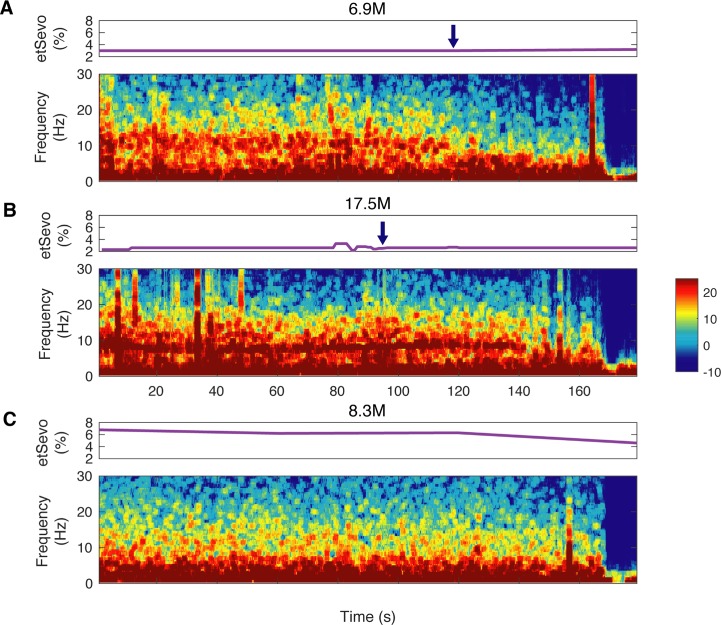
Spectrograms preceding discontinuous activity in individual subjects.Representative end tidal sevoflurane (etSevo) and spectrograms of minutes preceding first discontinuity in children at ages (A) 6 months-old, (B) 17 months-old, and (C) 8 months-old. Blue arrow indicates delivery of a propofol bolus.